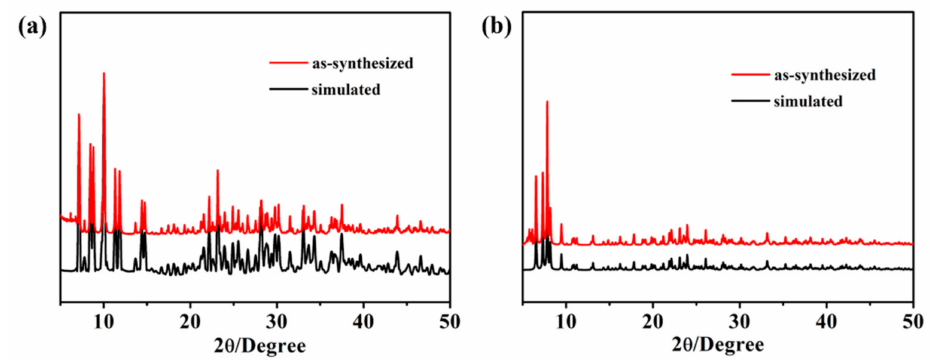
Figure 11. ( a ) PXRD pattern of catalyst 1 ; and ( b ) PXRD pattern of catalyst 2